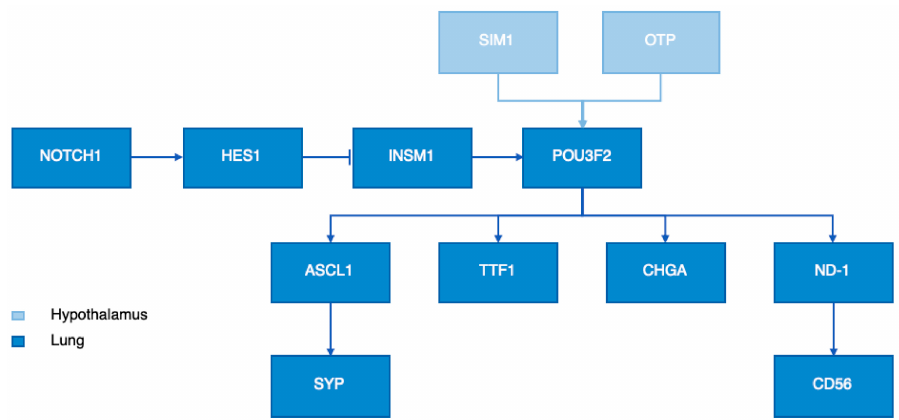
Figure 3. Proposed schematic overview of the molecular network through which OTP might act along with other neuroendocrine (NE) related factors in the hypothalamus and the lungs.